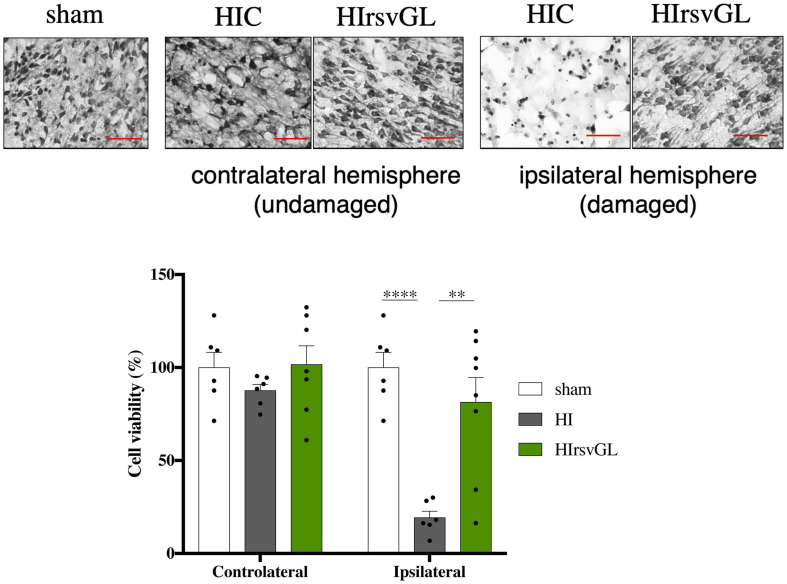
Evaluation of cell loss with or without resveratrol treatment after a hypoxic-ischemic event. Top panels: Nissl staining of 16 μm-thick cortical brain sections. Several neuro-morphological changes are observed in the pups from the HI group, with increased numbers of pyknotic cells and less Nissl stained nuclei. Maternal resveratrol supplementation preserved the number of Nissl stained nuclei (i.e., viable cells). Magnification ×20; scale bar: 100 μm. Bottom graph: Percentage of cell loss, based on the density of Nissl stained nuclei, for sham, HI, and HIrsvGL groups in either contralateral or ipsilateral cortex (n = 6). Results are mean values ± SEM, one-way analysis of variance (ANOVA) with Fisher’s LSD post hoc test. ∗: Significant difference between two groups (∗∗: p < 0.01 and ****: p < 0.0001).